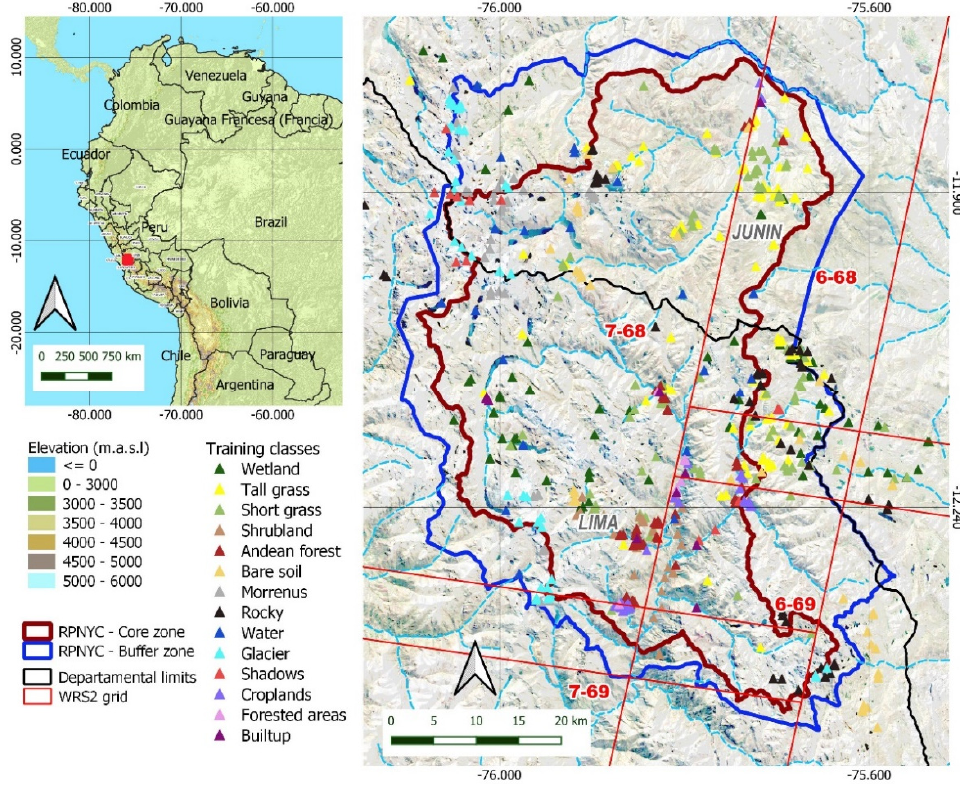
Figure 1. Location of RPNYC district in Peru ( left ) and map of RPNYC boundaries ( right ) with location of the training points by land cover type.